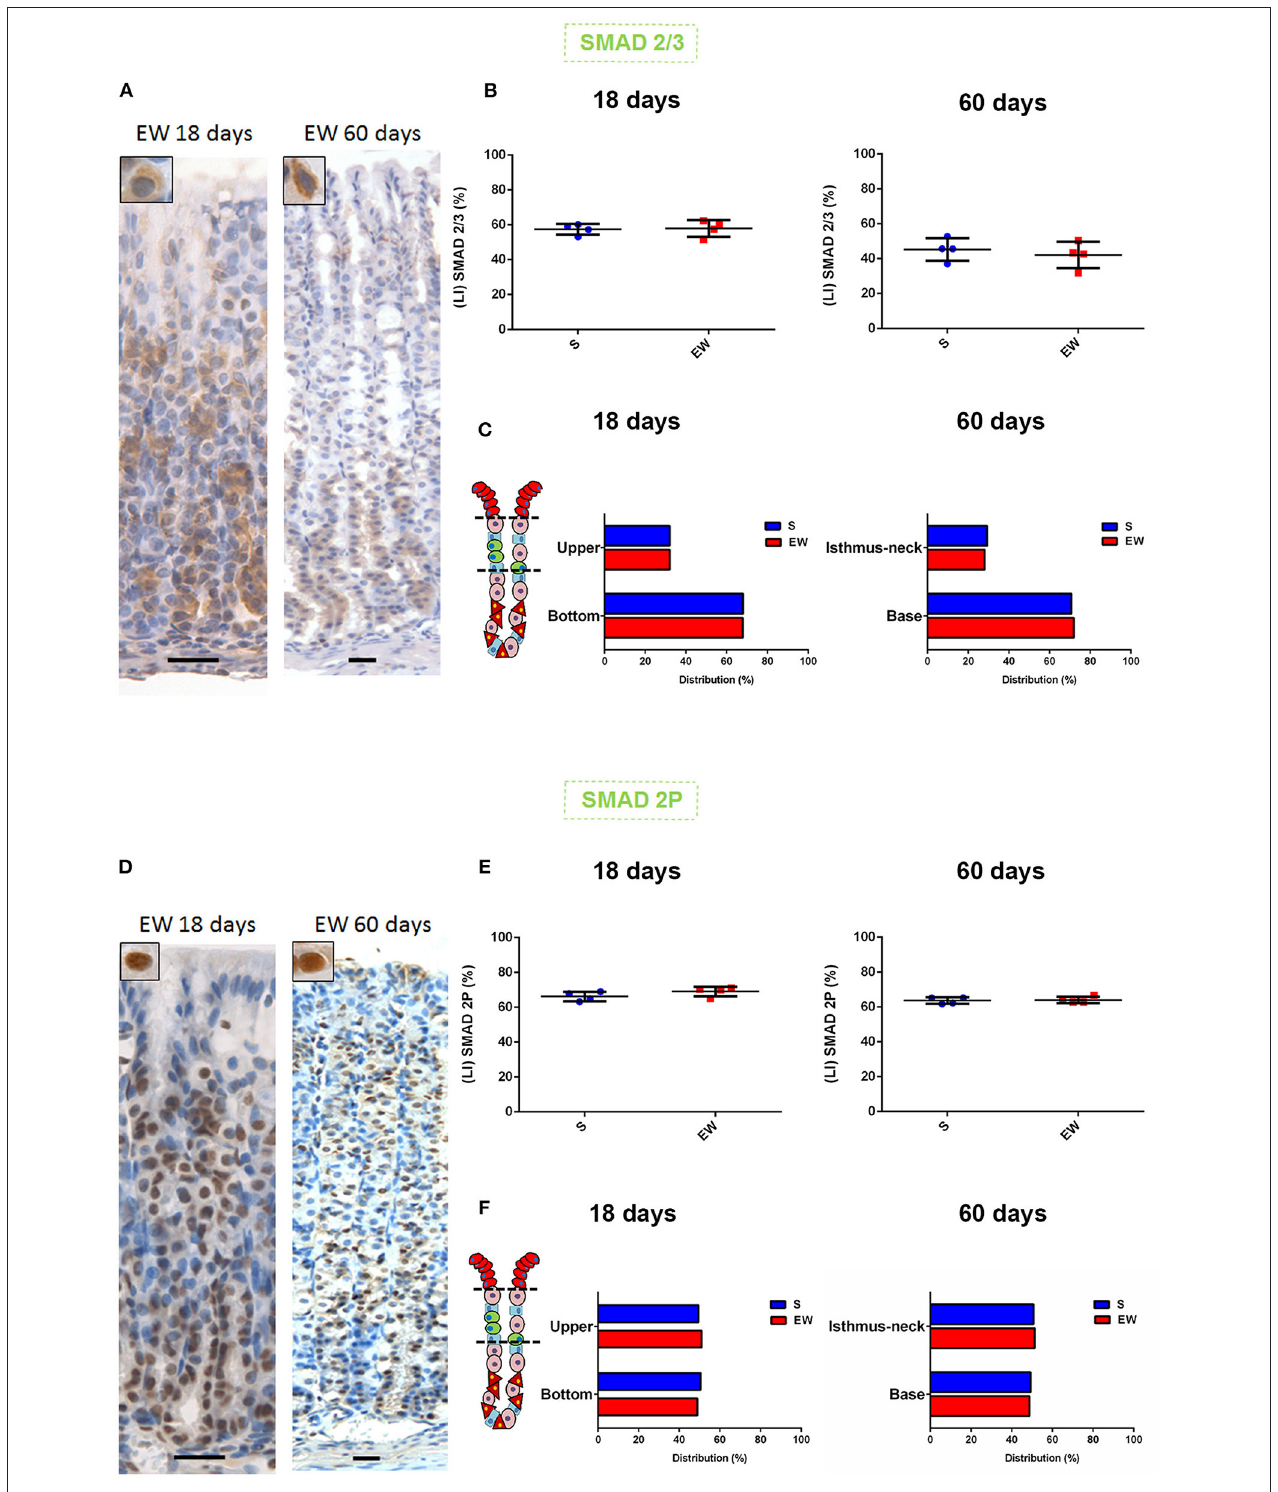
FIGURE 6 | Early weaning and the distribution of Smads in the gastric mucosa (A) . (D) Representative photomicrographs: gastric mucosa at 18 and 60 days after immunolabeling for Smad 2/3 and Smad 2P, respectively. Scale bar: 25 µ m. (B,E) Labeling index (LI) (%) for Smad 2/3 and Smad 2P, respectively, in S and EW rats (18 and 60 days). Results are represented individually and by means ± SD for S (blue) and EW (red). (C,F) Distribution of cells immunolabeled (%) for Smad 2/3 and Smad 2P, respectively, in the regions of the gastric gland in S and EW rats at 18 (as upper and bottom) and 60 (as isthmus neck and base) days. Bars represent the means for S (blue) and EW (red). Results were compared by Student’s t -test according to the age studied.